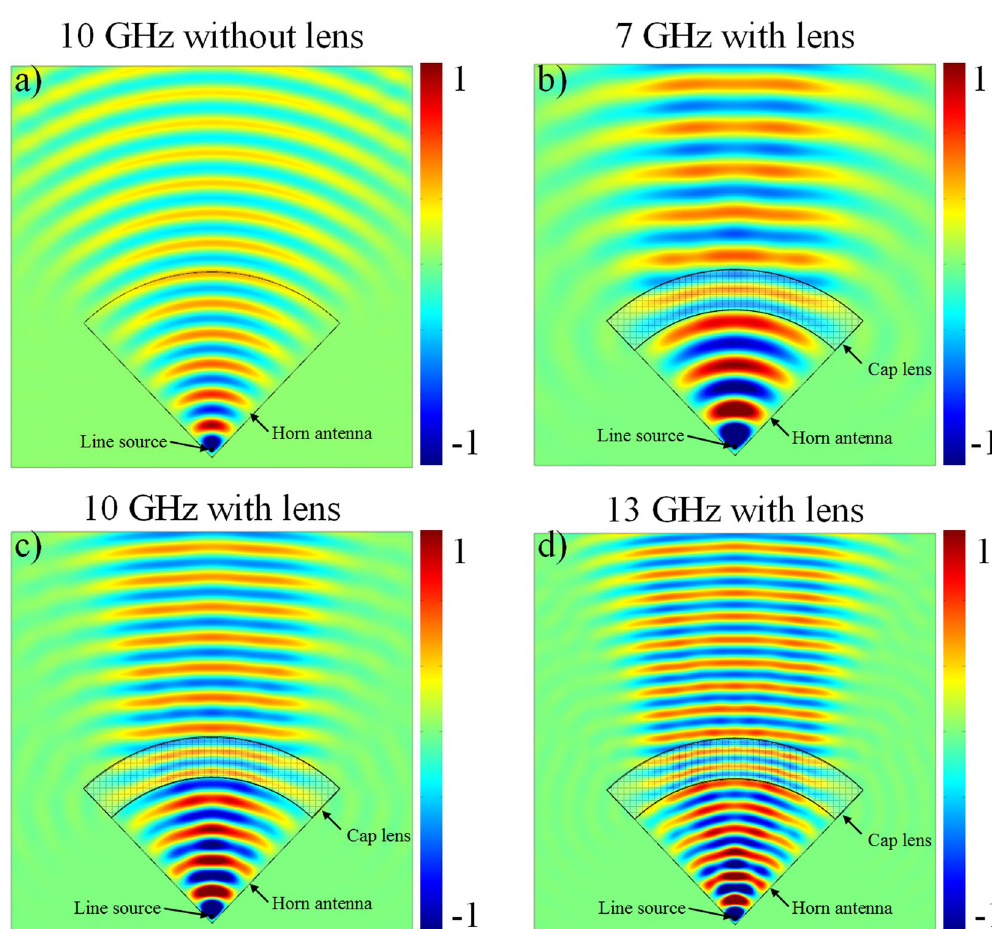
Figure 3. Calculated 2D electric field distribution of ( a ) conical horn antenna at 10 GHz, and conical horn antenna with cap lens at ( b ) 7 GHz, ( c ) 10 GHz and ( d ) 13